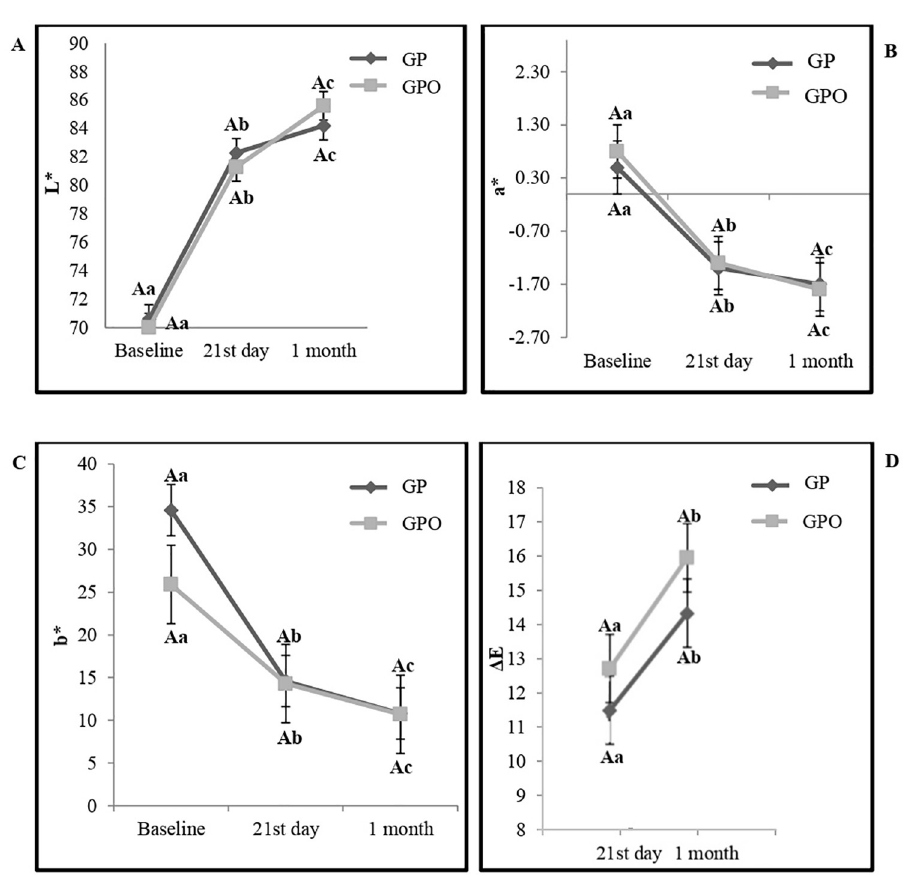
Fig 3. Color evaluation results for L � (A), a � (B), b � (C) and Δ E (D). � Different capital letters represent a statistically significant intergroup difference, according to the ANOVA Test (p � 0.05); � Different capital letters represent statistically significant intergroup difference (p � 0.05); �� Different lowercase letters represent statistically significant intragroup difference (p � 0.05).